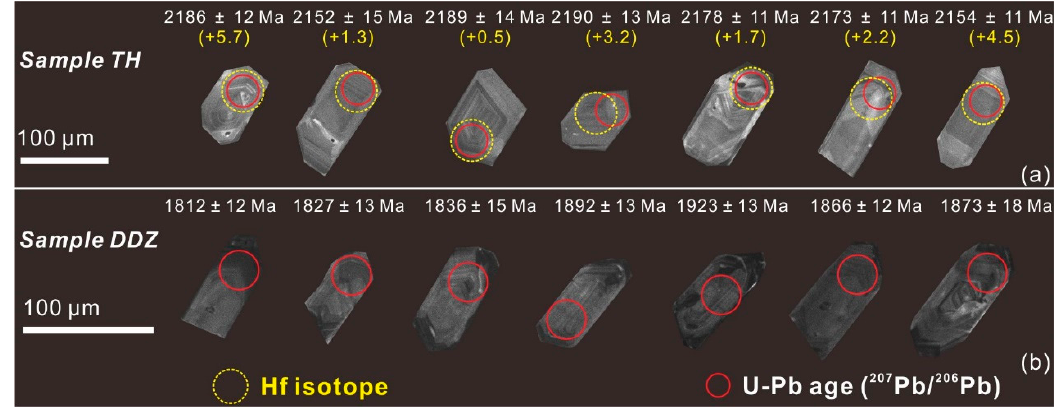
Figure 4. Cathodoluminescence images of representative zircons from magmatic rocks in the Qingchengzi district. ( a ) sample TH, ( b ) sample DDZ.